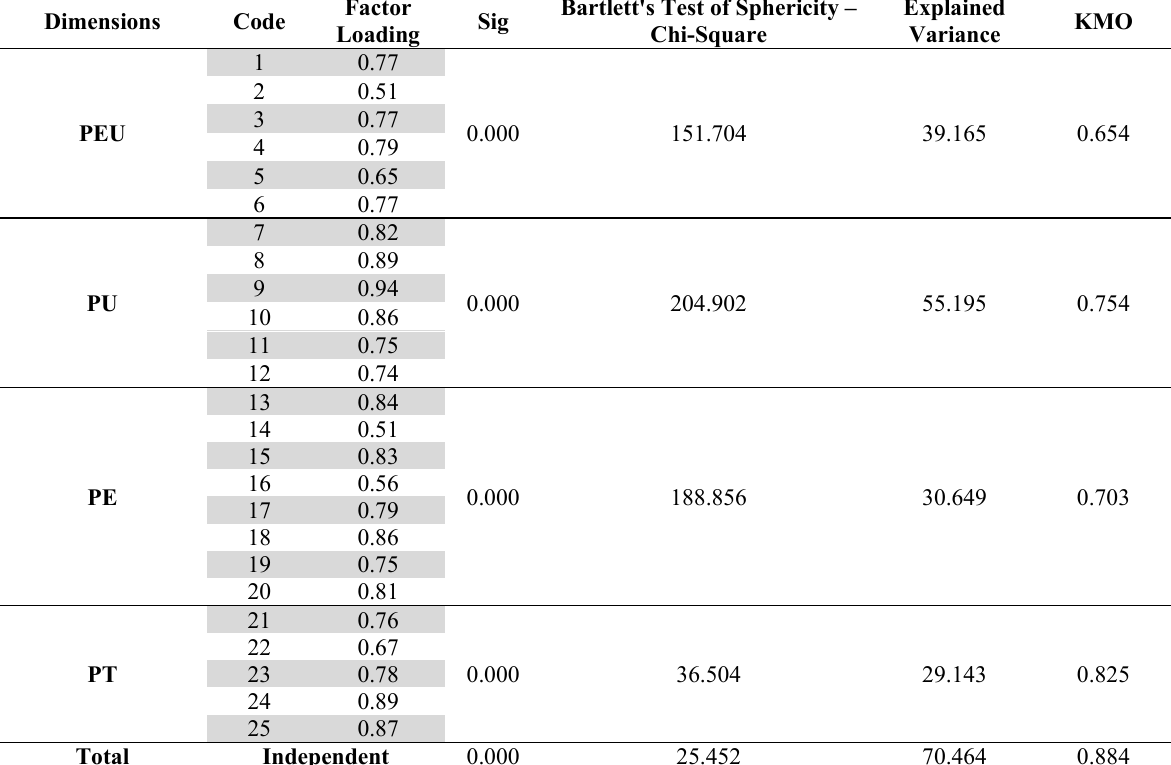
Table 3 EFA analysis for the items representing each factors of the Independent Variables